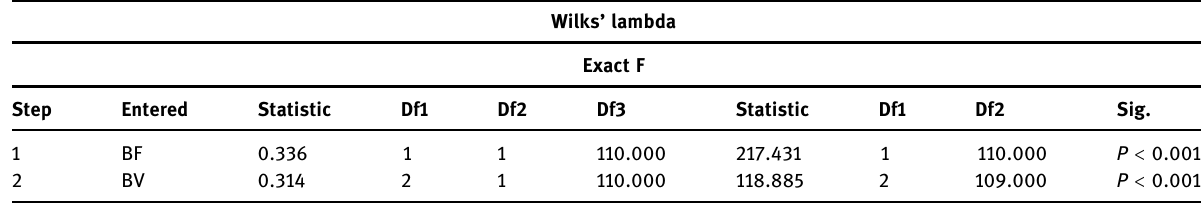
Table 2: BF and BV values are signi fi cant discriminators between groups of patients with nontumorous parenchymal tissue and PDAC Wilks ’ lambda